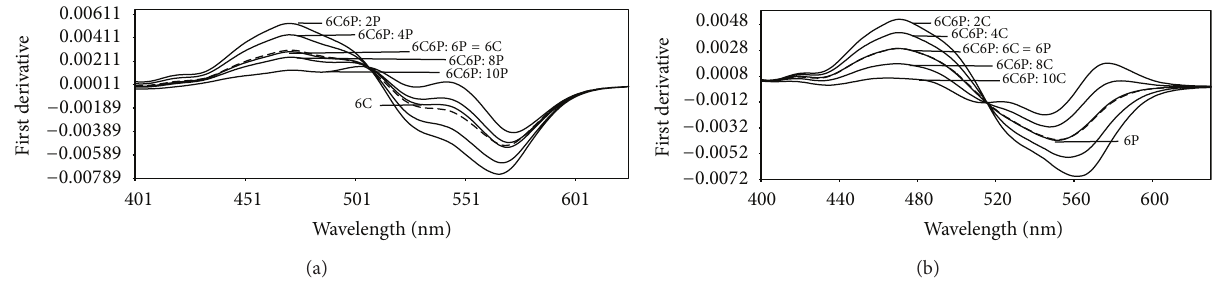
Figure 4: (a) First derivative spectra between the mixture solution (6 𝜇 gmL −1 Carmoisine + 6 𝜇 gmL −1 Ponceau 4R) in the sample cell and different concentrations (2–10 𝜇 g mL −1 ) of Ponceau 4R solutions in the reference cell. First derivative spectra between the mixture solution (6 𝜇 g mL −1 Carmoisine + 6 𝜇 g mL −1 Ponceau 4R) in the sample cell and 6 𝜇 g mL −1 Ponceau 4R in the reference cell at balance points and comparison of these spectra with 6 𝜇 gmL −1 concentration of Carmoisine (---) spectrum. (b) First derivative spectra between the mixture solution (6 𝜇 g mL −1 Carmoisine + 6 𝜇 g mL −1 Ponceau 4R) in the sample cell and different concentrations (2–10 𝜇 gmL −1 ) of Carmoisine solutions in the reference cell. Derivative spectra between the mixture solution (6 𝜇 gmL −1 Carmoisine + 6 𝜇 gmL −1 Ponceau 4R) in the sample cell and 6 𝜇 gmL −1 Carmoisine in the reference cell at balance points and comparison of these spectra with 6 𝜇 g mL −1 concentration of Ponceau 4R (-- -)